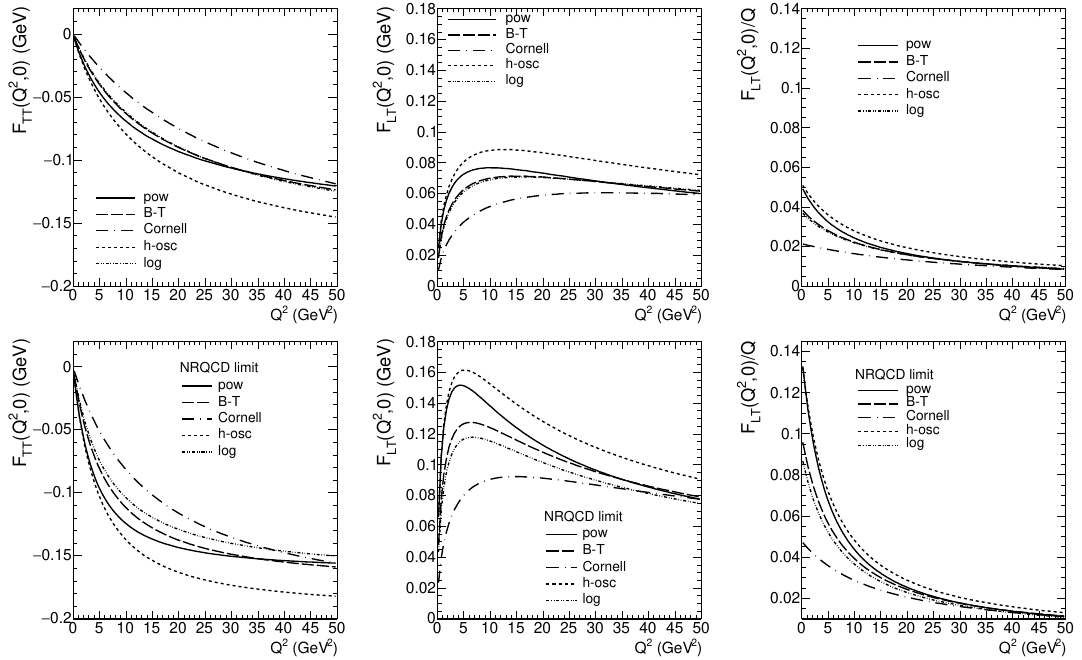
Figure 6 . Form factors F TT ( Q 2 , 0) , F LT ( Q 2 , 0) for one virtual photon (left and middle panels) and F LT ( Q 2 , 0) /Q (right panel). The top panels represent our results in the LFWF approach and the bottom panels correspond to the nonrelativistic